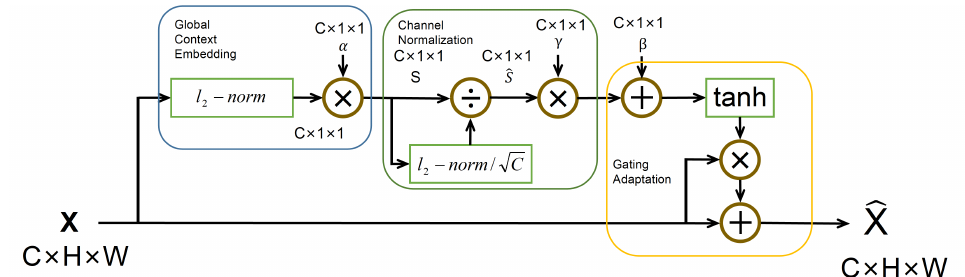
Figure 5. The structure of the Gaussian context transformer